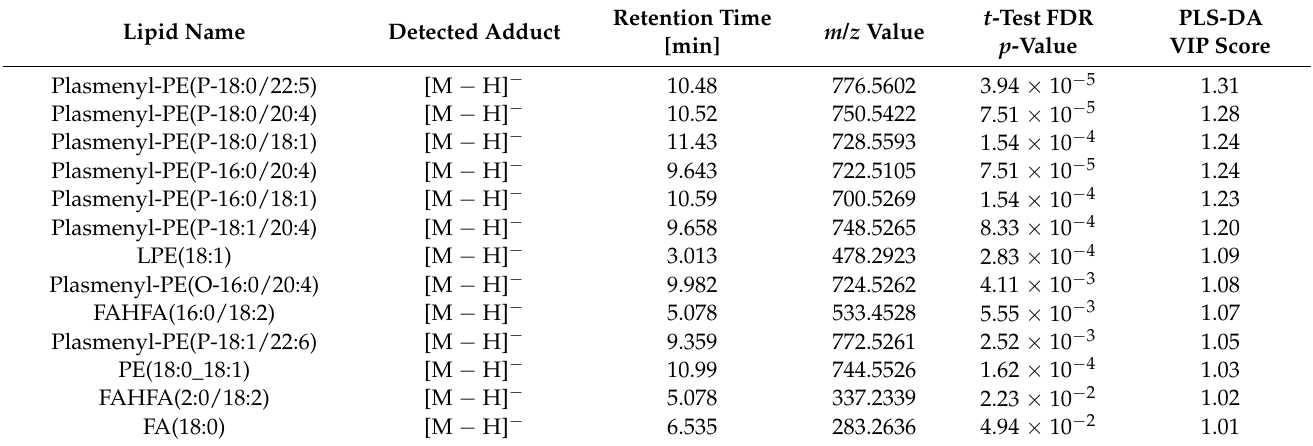
Table 1. List of detected lipids with variable importance on projection (VIP) score > 1 from a partial least squares discriminant analysis (PLS-DA) model built on lipids which passed a t -test p -value (FDR corrected) < 0.05 criterion and their characteristics.